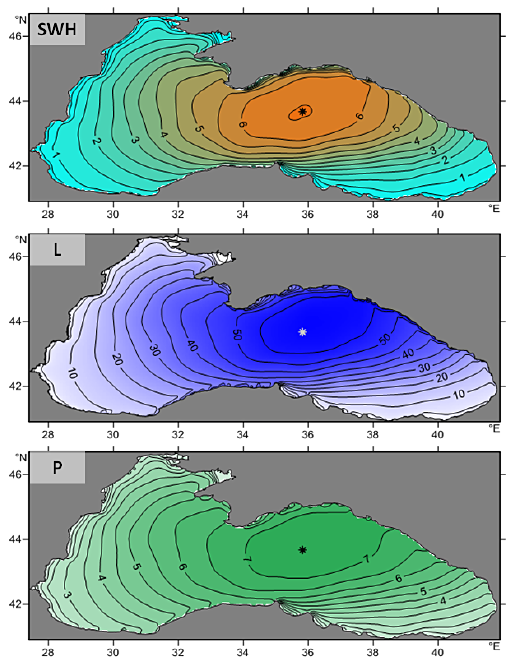
Figure 16. Maps of calculated significant wave height [m], wave length [m] and period [s] at 6hUTC, 11 November 2007. The lo- cation of maximal calculated SWH during the storm is indicated by symbol.